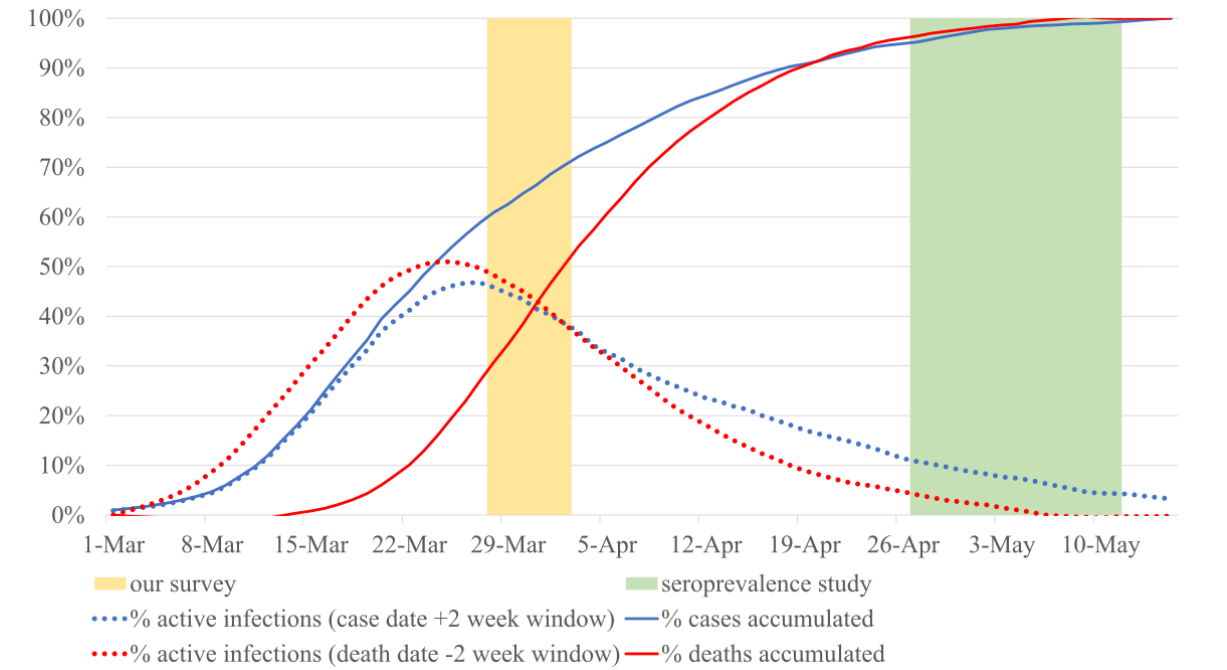
Figure 4. Two methods for estimating the proportion of active coronavirus infections during the time of our study in relation to those identified by the seroprevalence study. Red dotted line based on the Mortality Monitoring System deaths, assuming infection started 2 weeks prior to death. Blue dotted line based on reported positive cases, assuming infection ended 2 weeks after the case was reported. Cases and deaths from the Carlos III Health Institute in